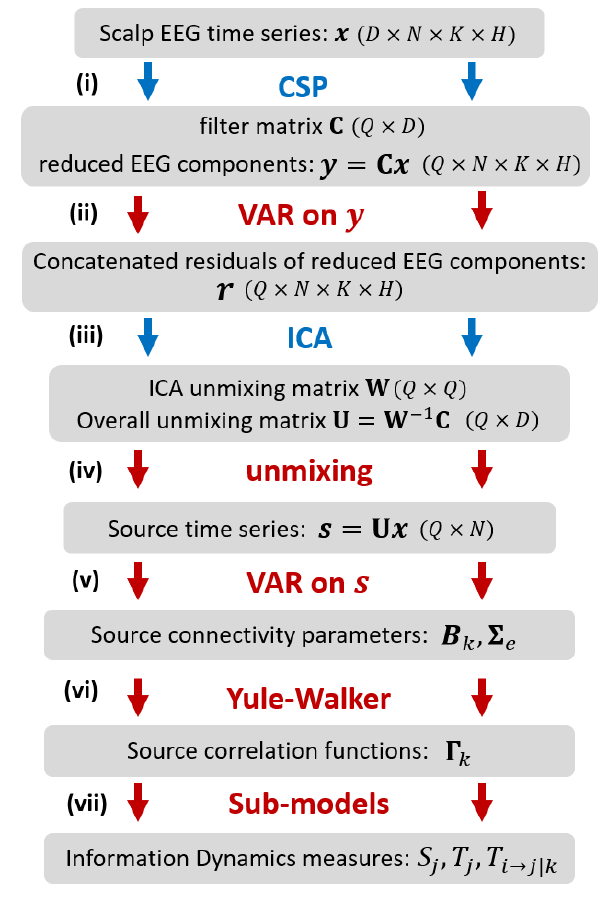
Figure 1. Description of the methodology adopted in this work to assess information dynamics of EEG cortical sources. The EEG signals (in the number of D signals, each with length of N samples, collected over K trials during H conditions) are reduced in dimension by CSP (from D signals to Q components), and their time-lagged and instantaneous interactions are described respectively by a VAR model and by ICA; then, source dynamics are reconstructed via unmixing of the scalp signals, their interactions are retrieved through VAR modeling and solution of Yule-Walker equations, and information measures are computed from sub-models relevant to specific sources. In the figure, blue and red arrows refer to analysis steps performed on the whole dataset and on single trials, respectively. More details on the analysis are provided in the